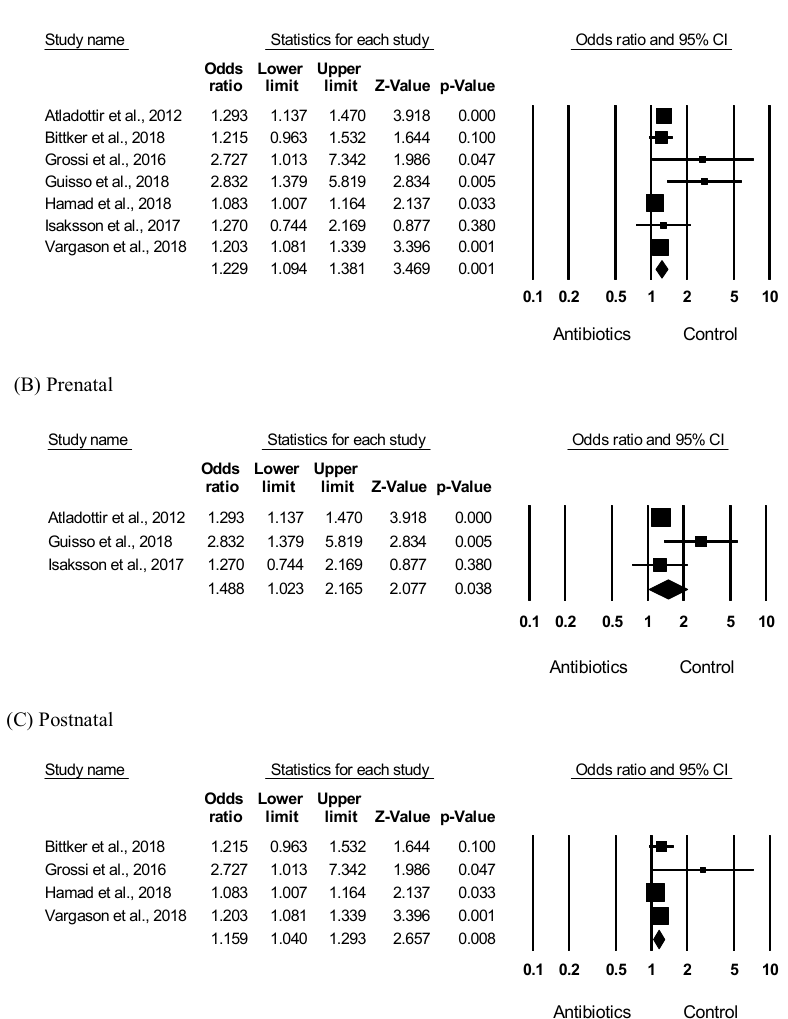
Fig 2. Meta-analysis of the odds ratio estimate of ASD risk according to antibiotic exposure in children